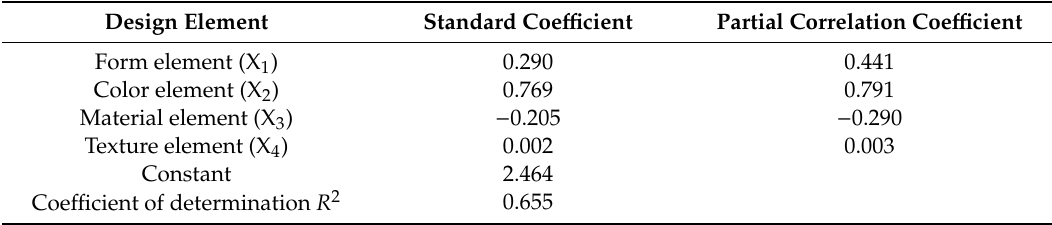
Table 2. Analysis of result from Quantification Theory Type